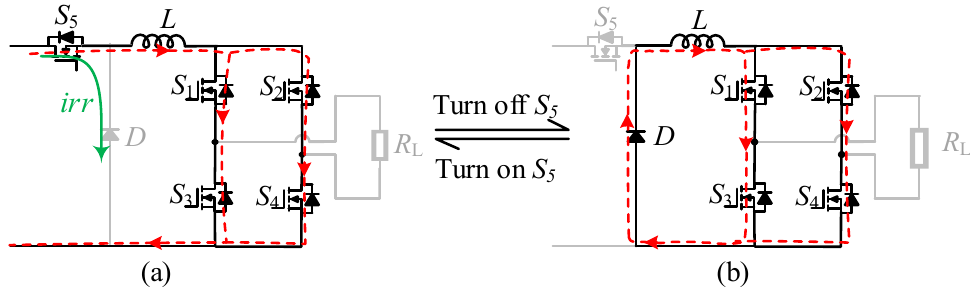
Figure 13. The communication between the charging and discharging states: ( a ) the charging state, and ( b ) the dead-time of the discharging state.